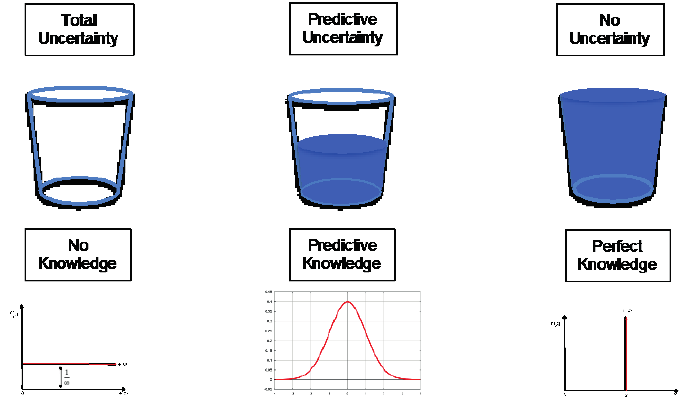
Fig. 1 The representation of predictive uncertainty and predictive